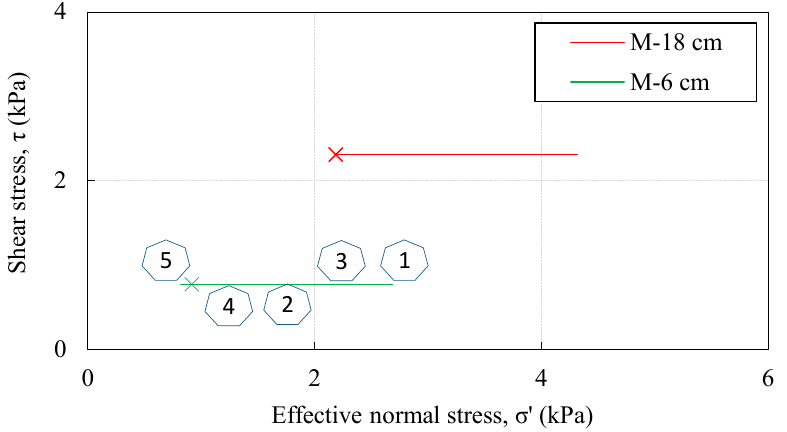
Figure 13. Stress paths calculated using equation (3) and the data collected in Example 2 for monitoring points along the M-profile at 6 (M-6) and 18 (M-18) cm depth.